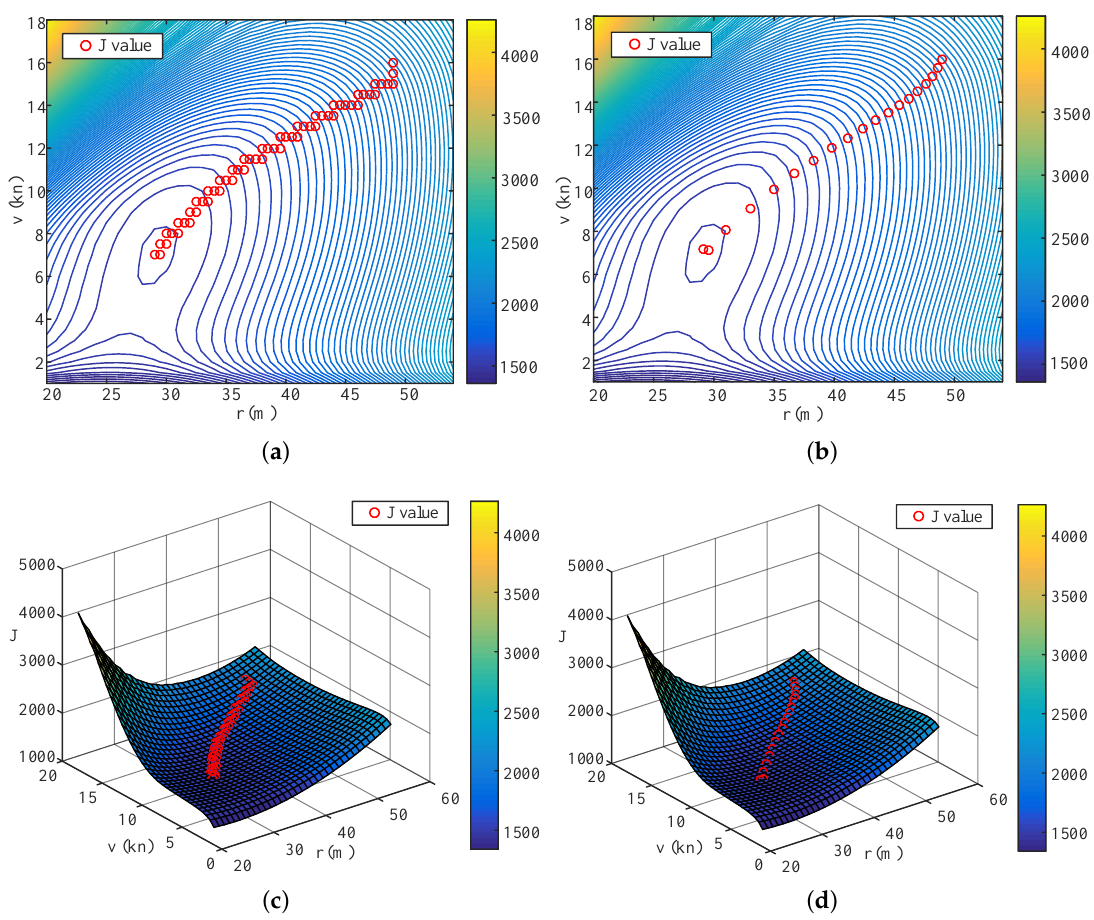
Figure 10. Diagram of descending processes with the first group initial values: ( a , c ) are the iterative processes of TPA-IPT, and ( b , d ) are the corresponding results of the normal